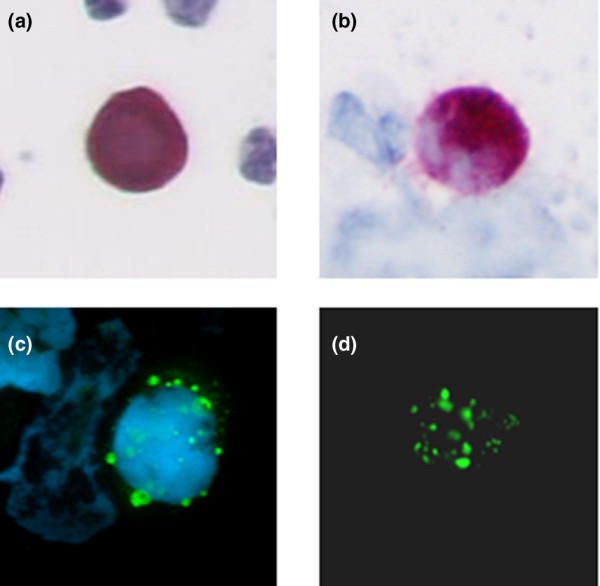
Disseminated apoptotic and nonapoptotic disseminated tumor cells. (a) Nonapoptotic disseminated tumor cell (DTC) (detected by the APAAP kit method). (b) Apoptotic DTC identified by M30 staining and morphological assessment (for example, membrane blebbing, nuclear shrinkage) (APAAP kit detection method). (c) Apoptotic DTC identified by morphological assessment (nuclear shrinkage, cytokeratin inclusions) (DTC detected by a fluorescein-5-isothiocyanate-labeled anticytokeratin antibody). (d) Apoptotic cell body without detectable amounts of chromatin.